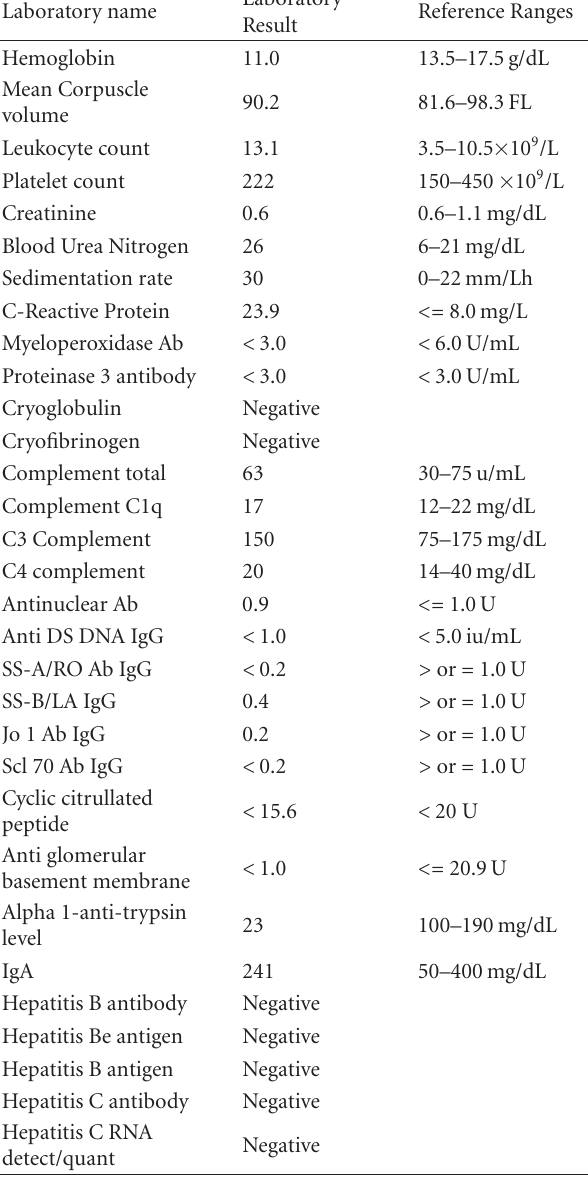
Table 1: Pertinent laboratory